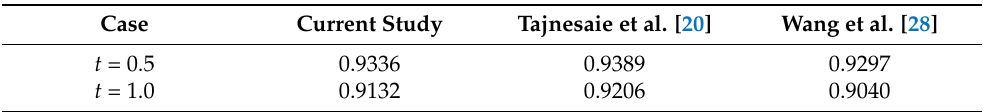
Table 2. Correlation coefficients between the experimental and numerical results on the water profiles.